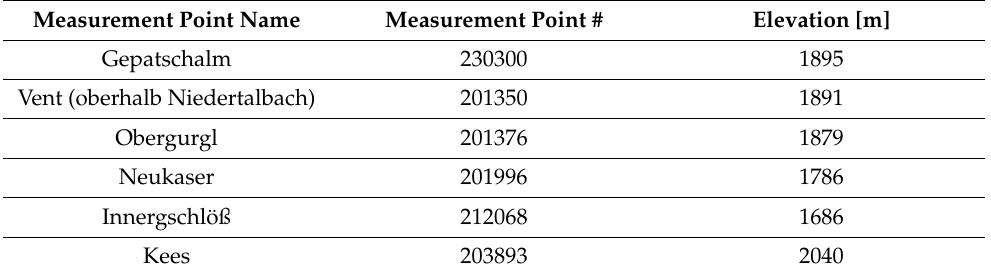
Table A3. Measurement points used for annual (pumped)-storage hydropower plant inflow SLP